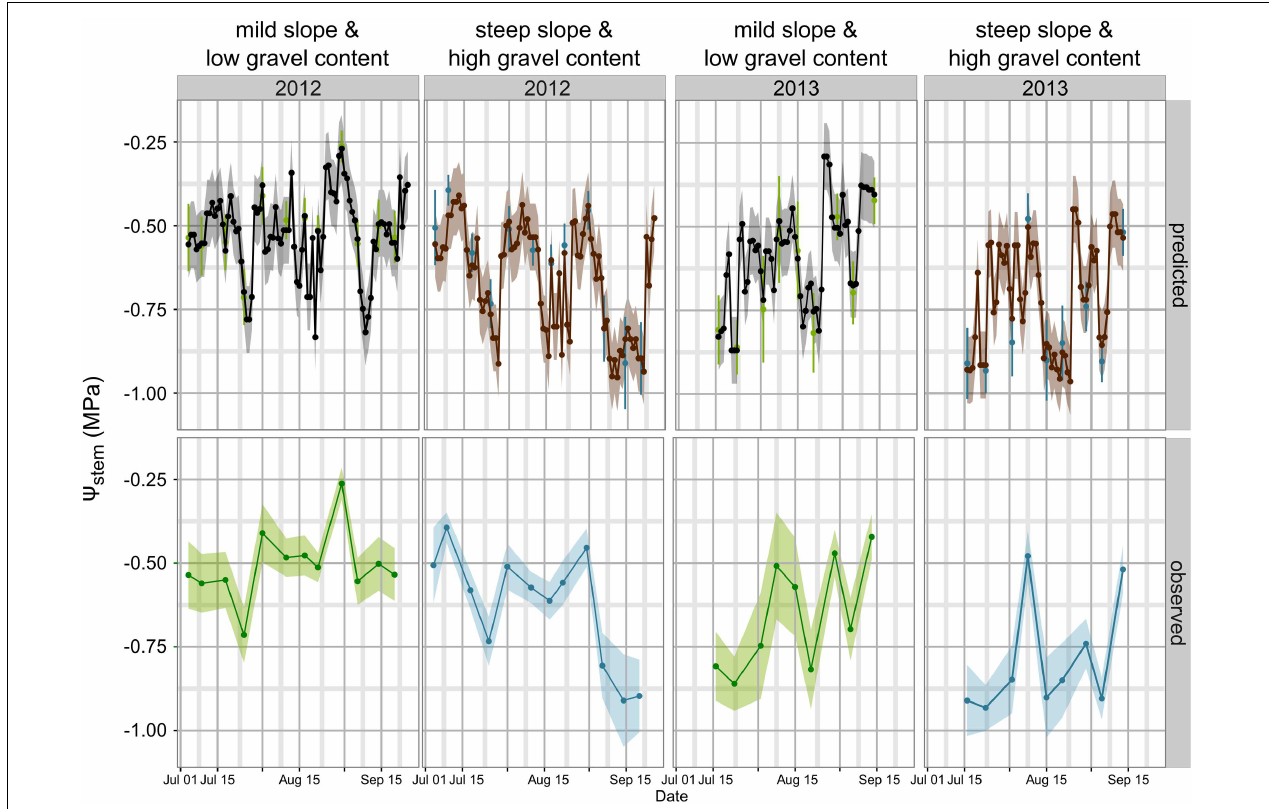
FIGURE 3 | Model simulations for (cid:57) stem in 2012 and 2013 between bunch closure and harvest. Veraison was approximately 15–16 August in both years. Two extreme scenarios are presented: (1) mild slope and low gravel content (clay-loam texture): lower water stress; and (2) steep slope and high gravel content (loam texture): higher water stress. For observed data the standard deviation of measurements is the shaded area in lower panel trends, and error bars for green and blue points in the upper panel. For predicted trends, the shaded area is equal to 0.1 MPa, the maximum estimated RMSE error in cross-validation (upper panel).